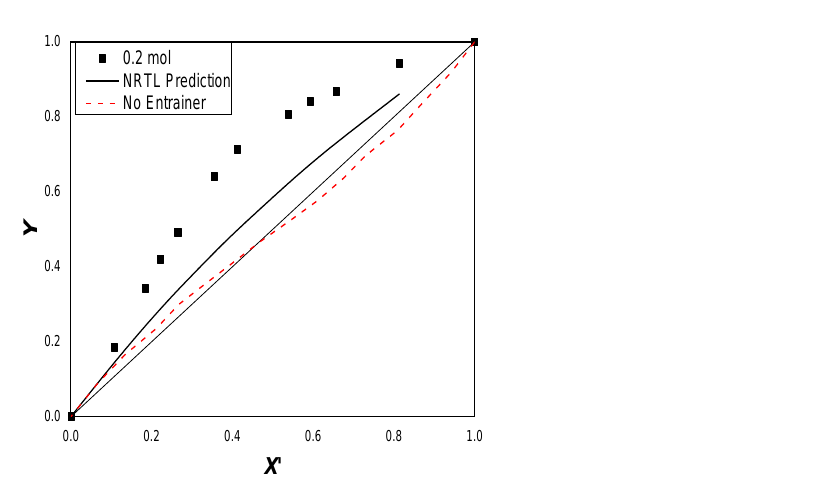
Figure 14. FT−IR spectra of DES(1:1), benzene and DES(1:1) + benzene(DES 0.1 (molar concentra- tion)). 4000